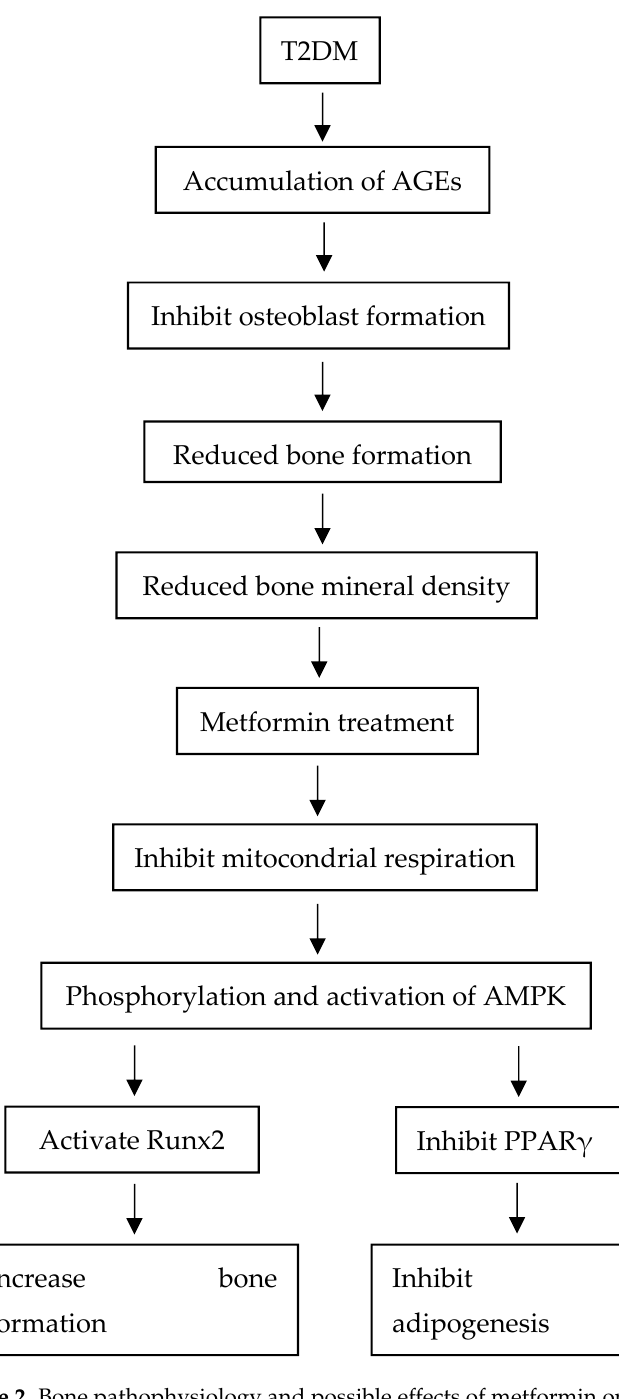
Figure 2. Bone pathophysiology and possible effects of metformin on BMD and adiposity [16].